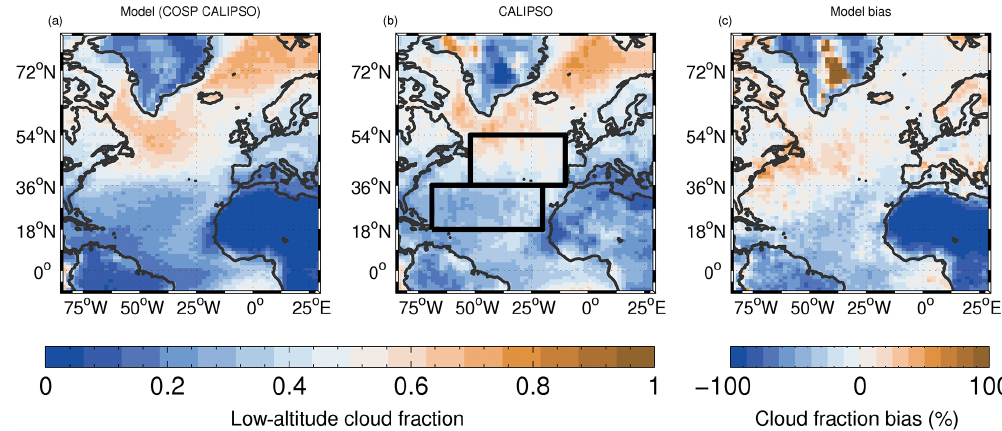
Figure 1. Low-altitude (CTP ≥ 680hPa) cloud fraction evaluation. (a) Model; (b) CALIPSO satellite data; (c) model bias. For the model, we are using the COSP simulator for CALIPSO to deal with the satellite cloud detectability threshold and overlying layers.